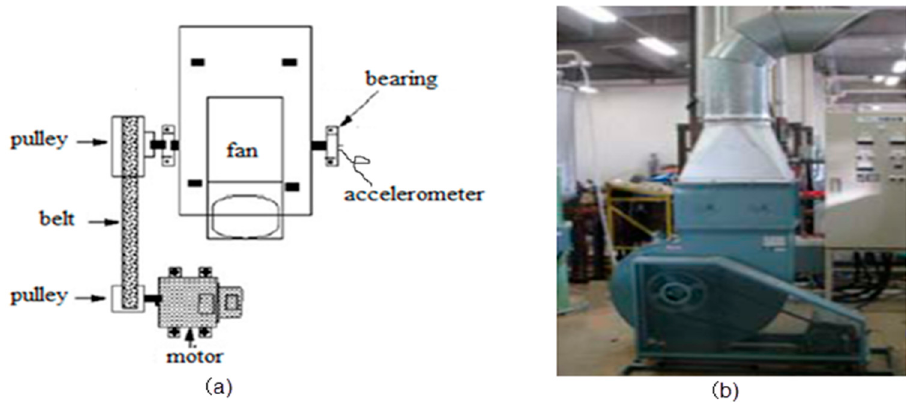
Figure 6. Centrifugal fan for condition diagnosis: ( a ) illustration of a centrifugal fan; and ( b ) photograph of a centrifugal fan.